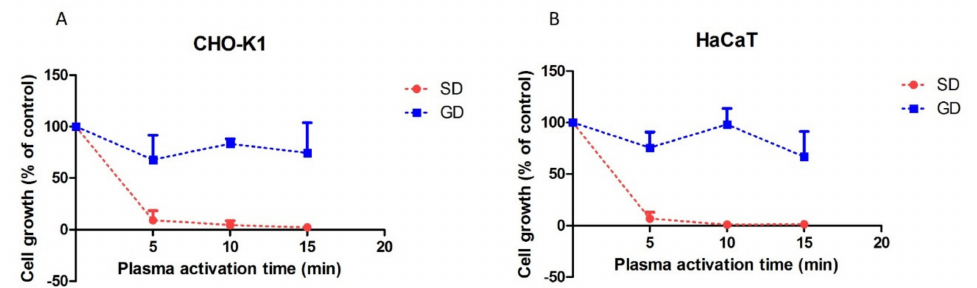
Figure 7. Cell growth of CHO-K1 ( A ) and HaCaT ( B ) cell lines exposed to PAW generated by SD and GD discharge at 20% ( v/v ) as plasma activation time of PAW increases (data shown as mean ± SD, n = 3).